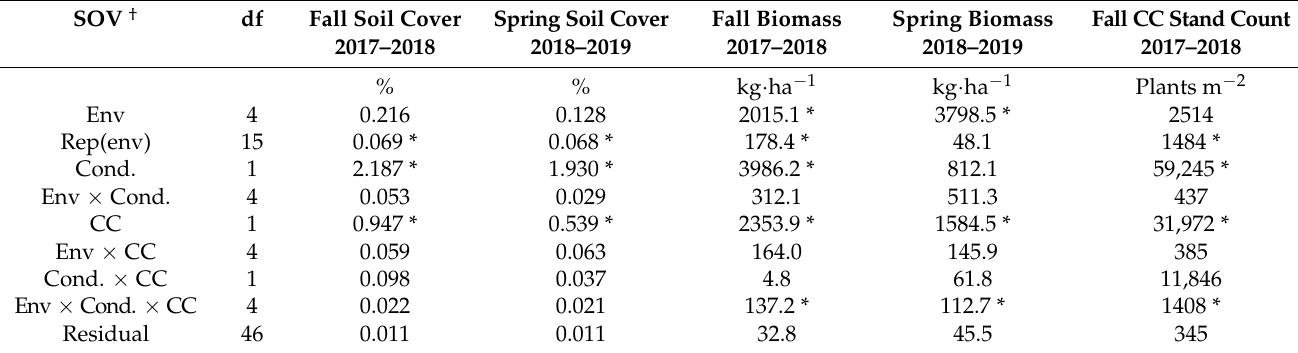
Table 5. Mean squares for two soybean conditions (‘Soy’ and ‘No-Soy’) and two cover crops (CC) in five environments at Fargo and Casselton, ND, 2017, 2018, and 2019. SOV † df Fall Soil Cover Spring Soil Cover